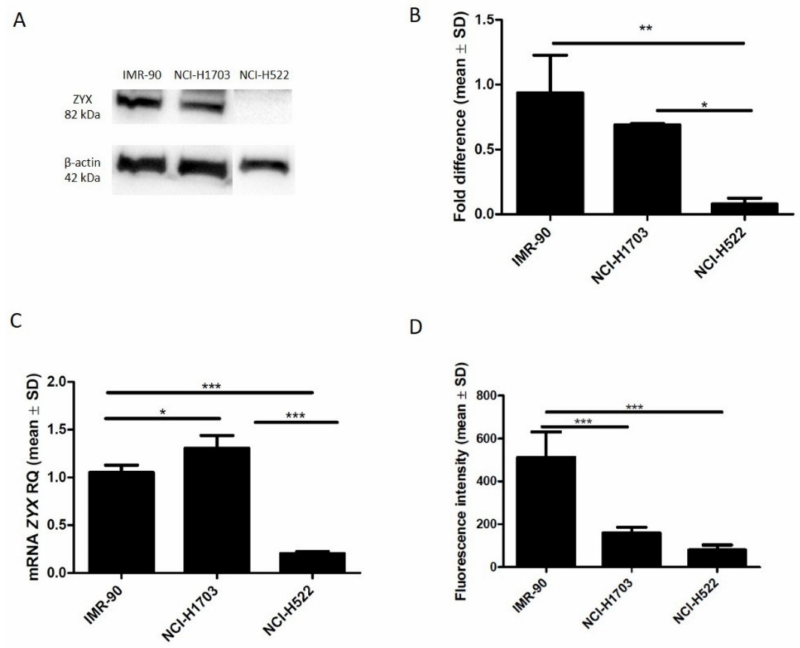
Figure 3. Expression of ZYX in the IMR-90 normal lung fibroblast cell line and in NSCLC cell lines: NCI-H1703 (lung squamous cell carcinoma) and NCI-H522 (lung adenocarcinoma). Western Blot ( A ) and densitometric analysis ( B ) of ZYX protein levels. ZYX mRNA expression in the cell lines ( C ). ZYX expression levels determined by measuring fluorescence intensity in the cell lines ( D ). Bonferroni multiple comparisons test (*** p < 0.001; ** p < 0.01; * p <